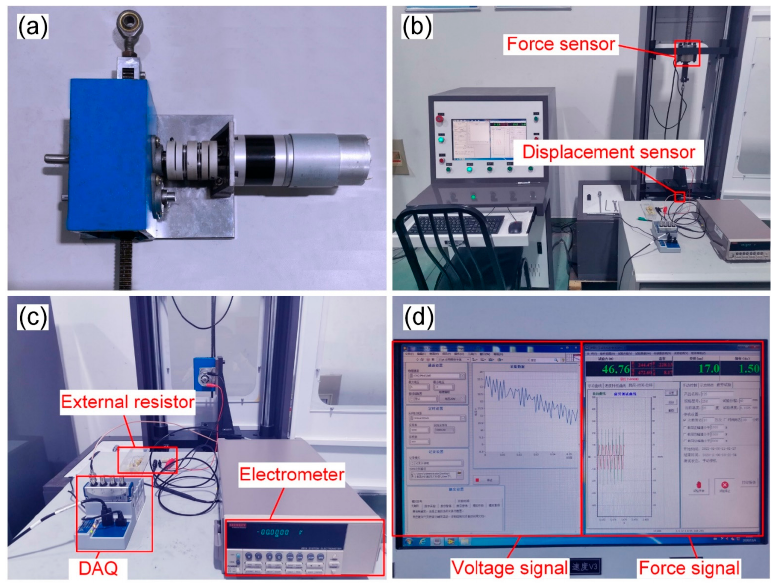
Figure 7. Lab testing. ( a ) EHSA prototype. ( b ) Dynamic test. ( c ) Electric test. ( d ) Voltage signal and force signal.